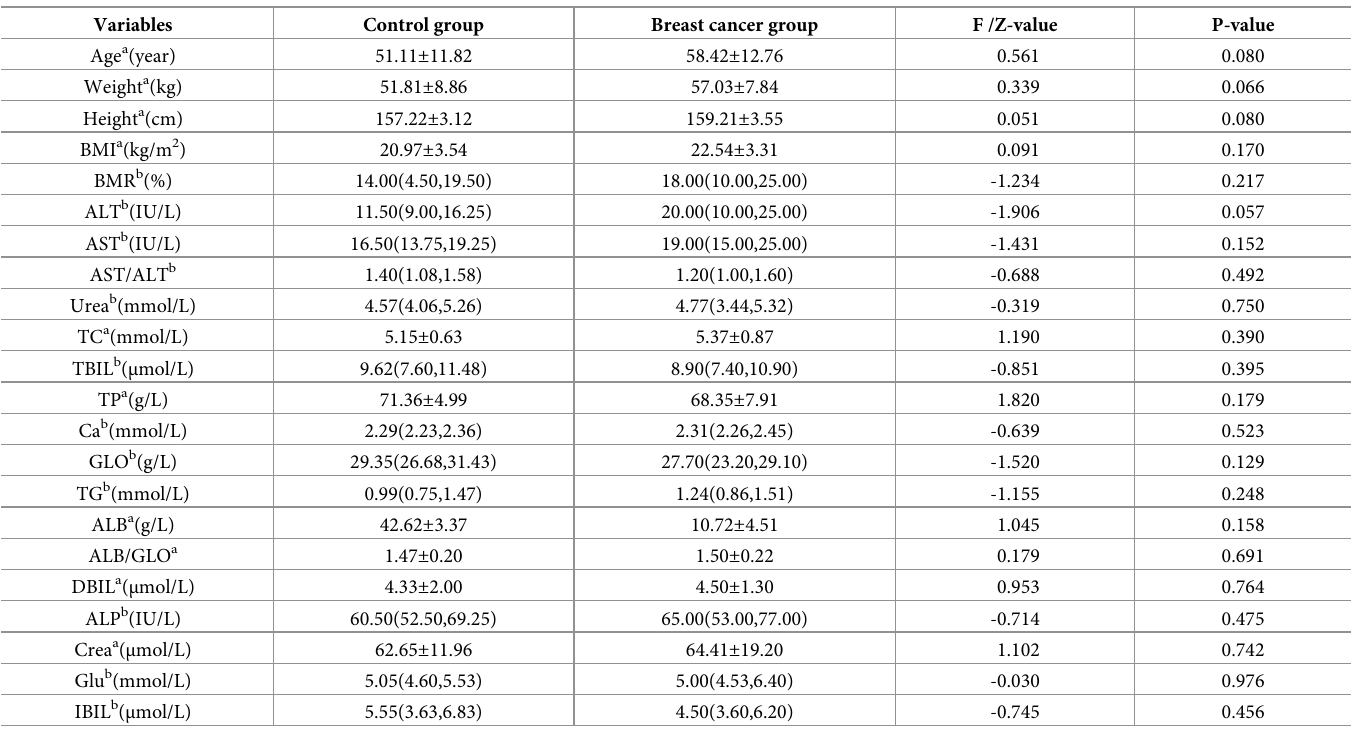
Table 1. Comparison of general information between the two